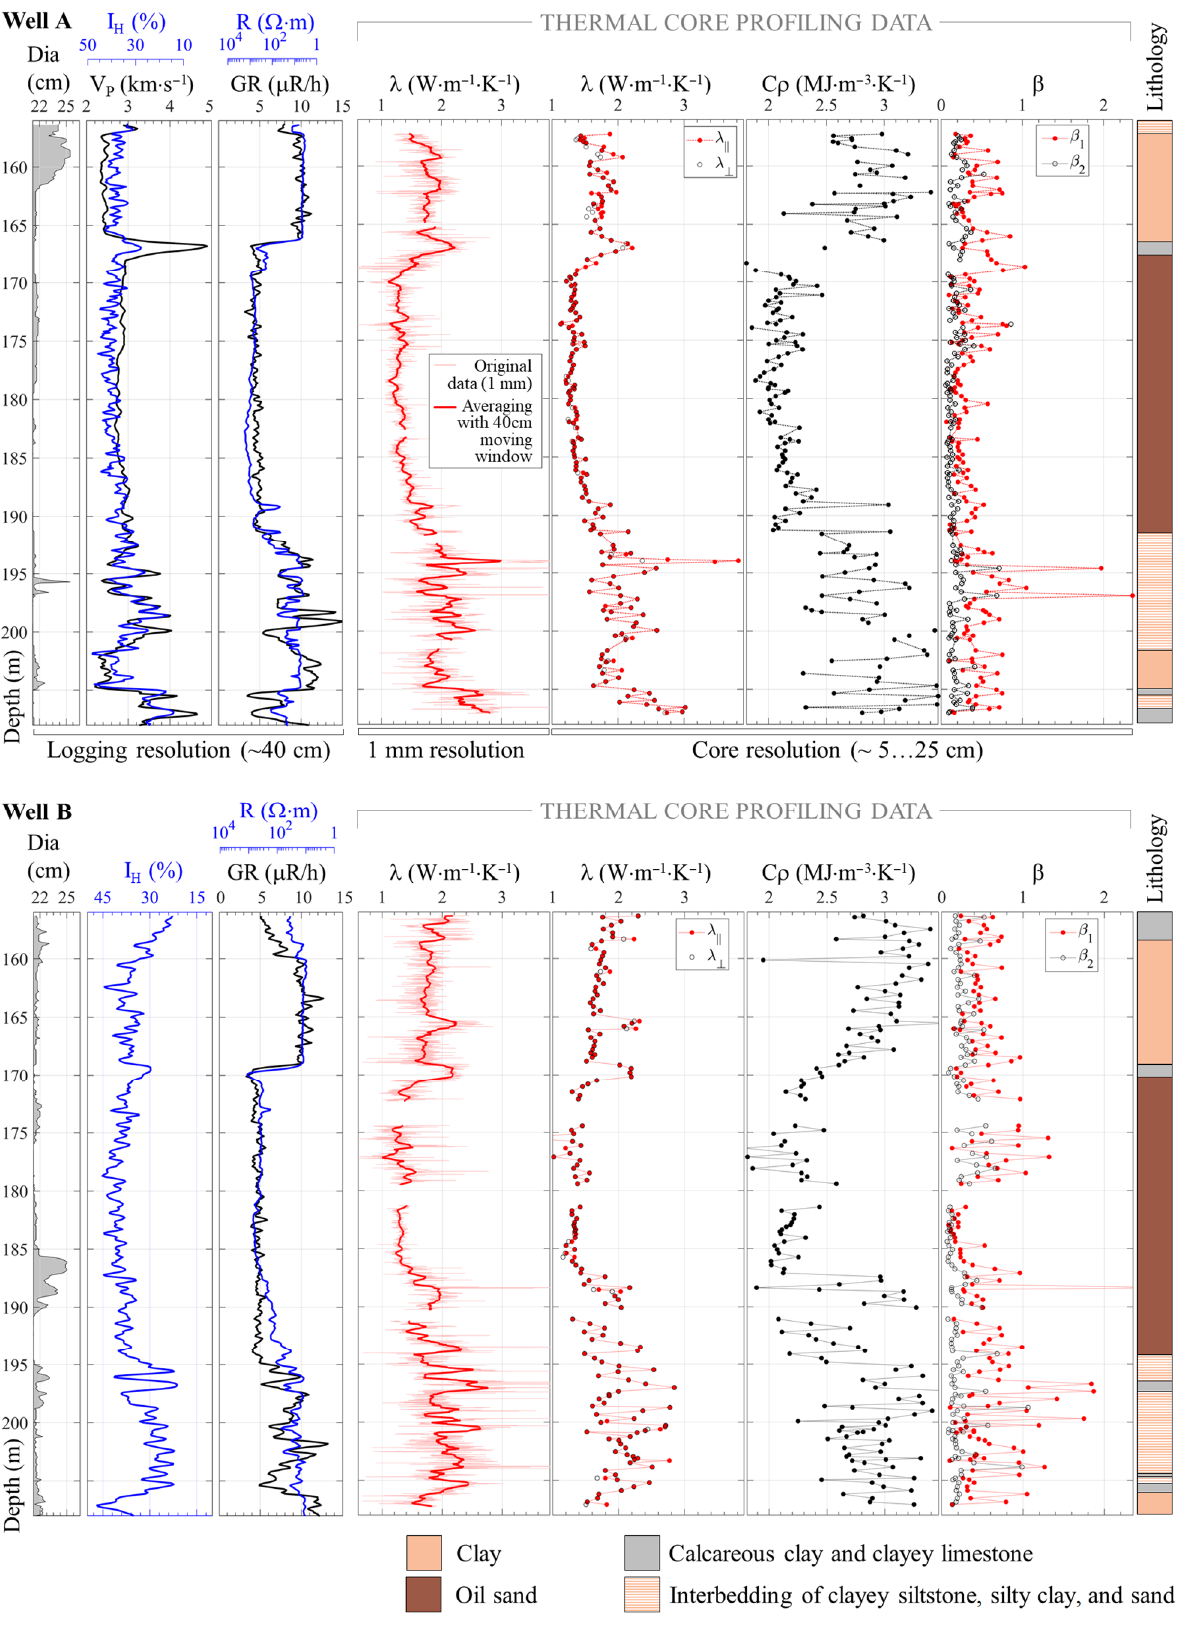
Figure 4. Results of thermal profiling at different scales on well logging plots for wells A ( top ) and B ( bottom ); see comments in text.